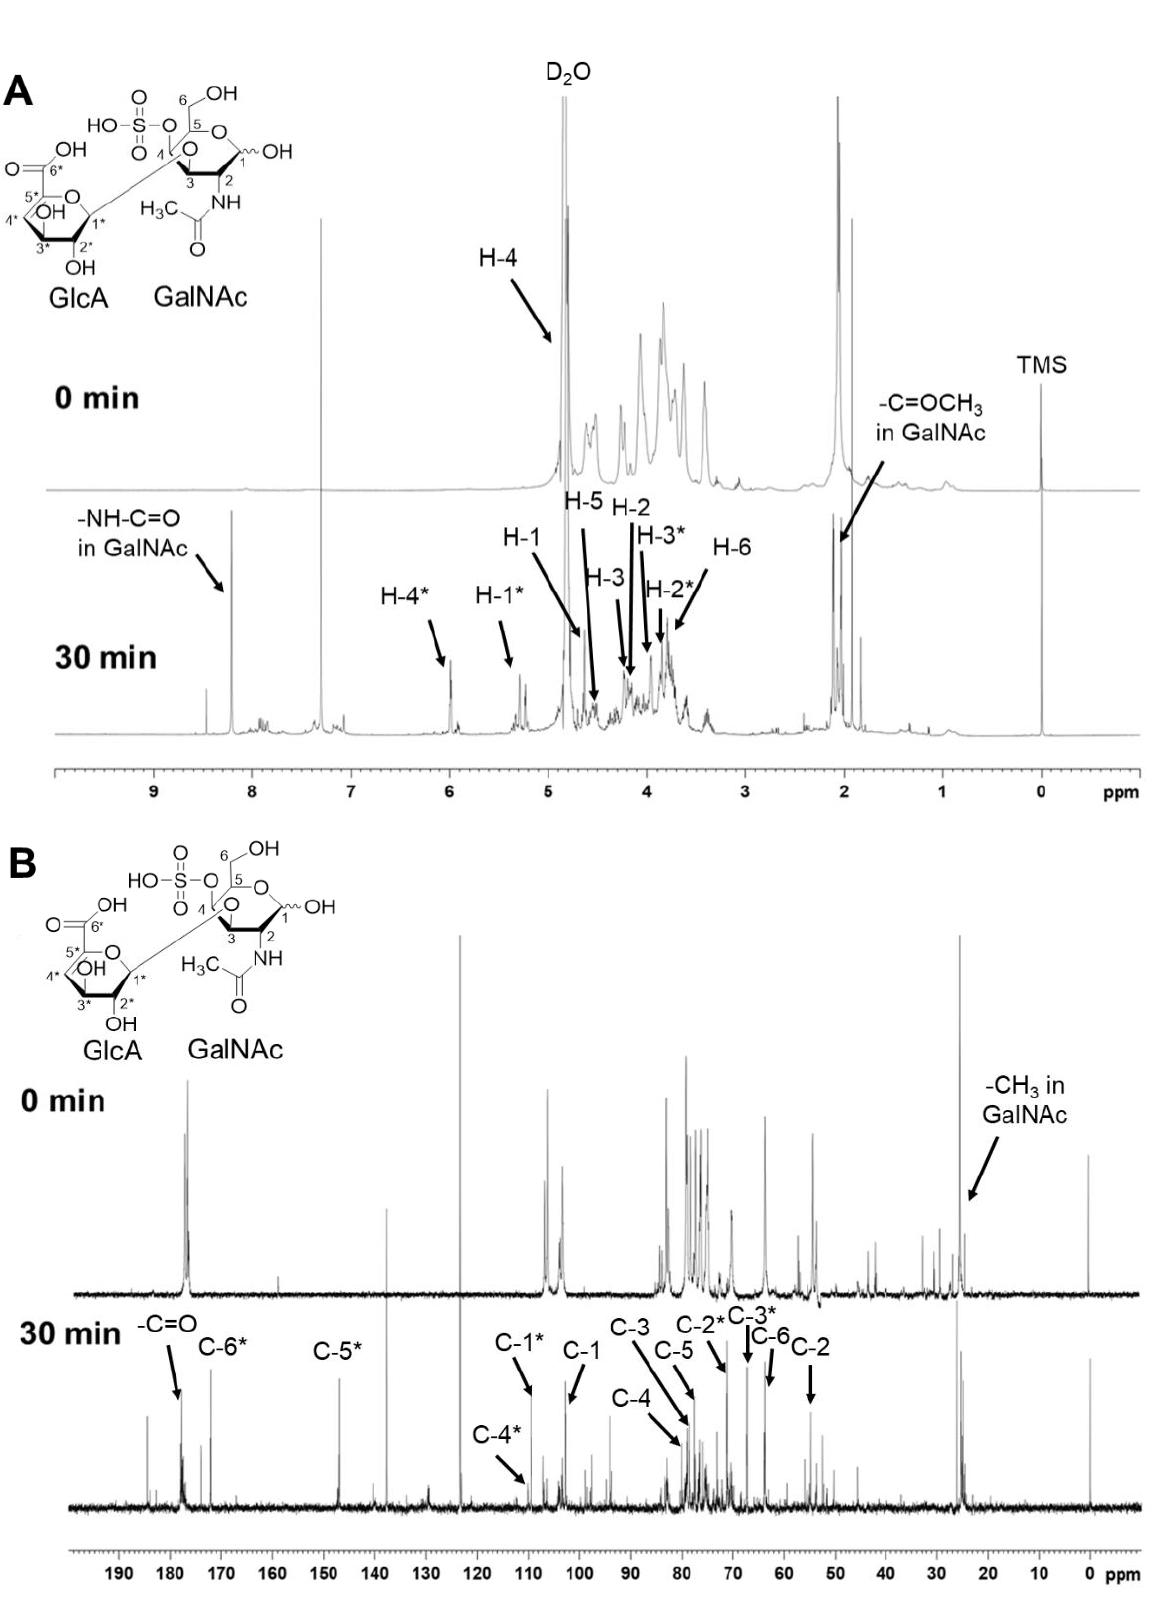
Figure 7. 1 H NMR ( A ) and 13 C NMR ( B ) spectra of the CS and hydrolyzed CS. GlcA: glucuronic acid; GalNAc: N-acetylgalactosamine. The 1 H NMR and 13 C NMR spectra were obtained using an Agilent DD2 spectrometer at 25 °C, and the nuclear magnetic frequency was 600 MHz.